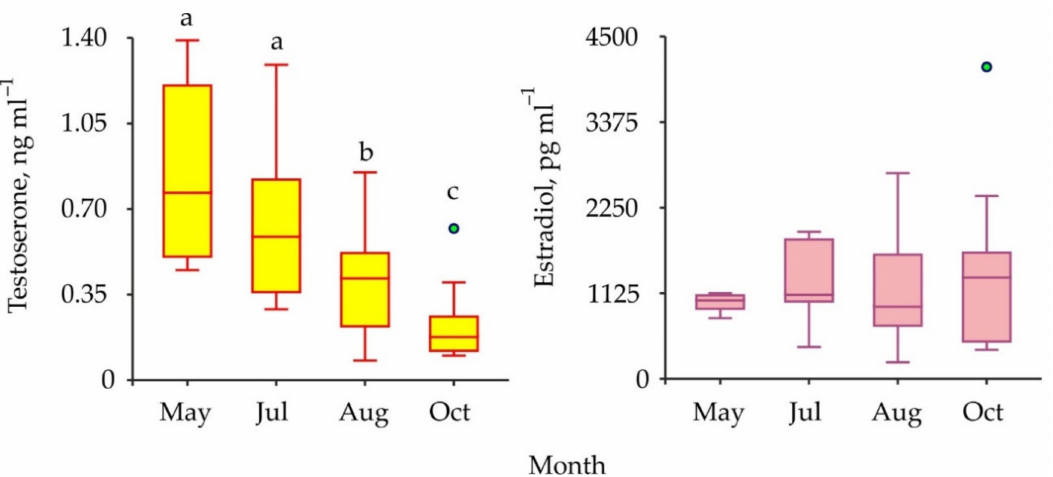
Figure 4. Seasonal variations in vertebrate-type sex hormones in hemolymph of red king crabs from the Barents Sea. Green circles are outliers. Bars with the same letter are not significantly different ( p > 0.05).